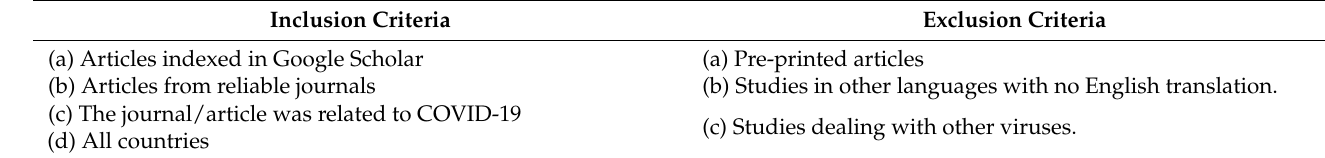
Table 1. Inclusion and exclusion criteria.